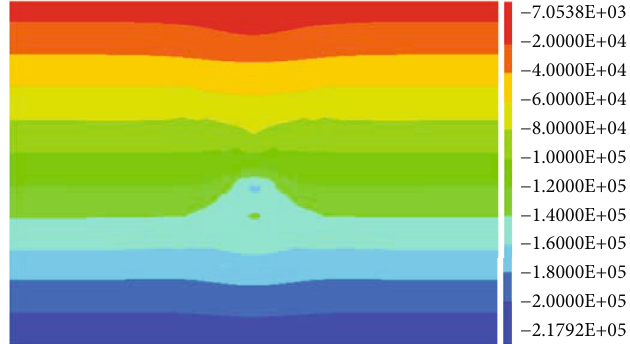
Figure 14: Initial horizontal stress nephogram.